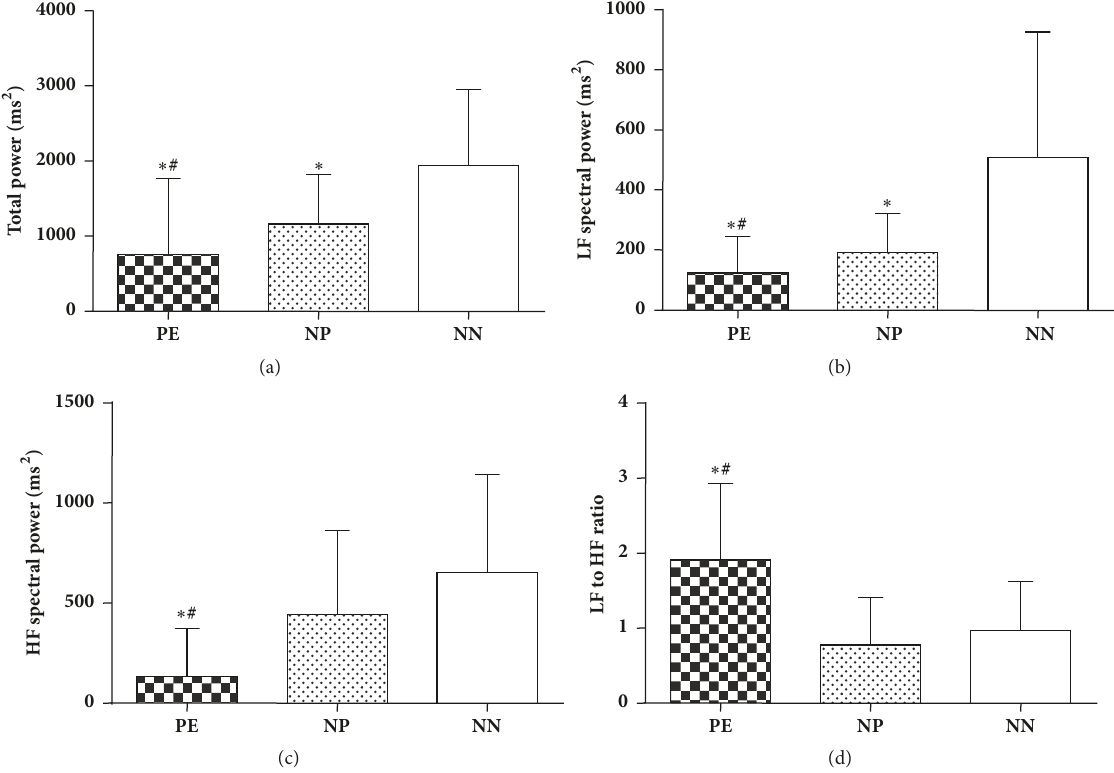
Figure 3: Comparison of spectral components of heart rate variability in 3 groups of subjects; PE, preeclampsia; NP, normotensive pregnant; NN, normal nonpregnant. (a) Total spectral power; (b) LF, low frequency power; (c) HF, high frequency power; (d) LF to HF ratio. Values are mean ± SD (n=40). ∗ p < 0.05 versus normal nonpregnant females; # p < 0.05 versus normotensive pregnant females.